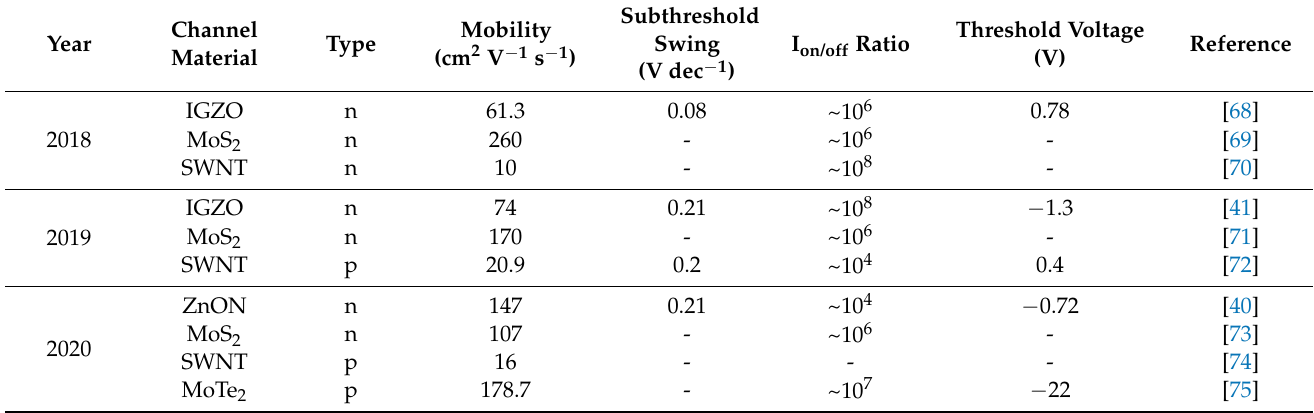
Table 1. Summary of TFT parameters using oxides, TMDCs, and